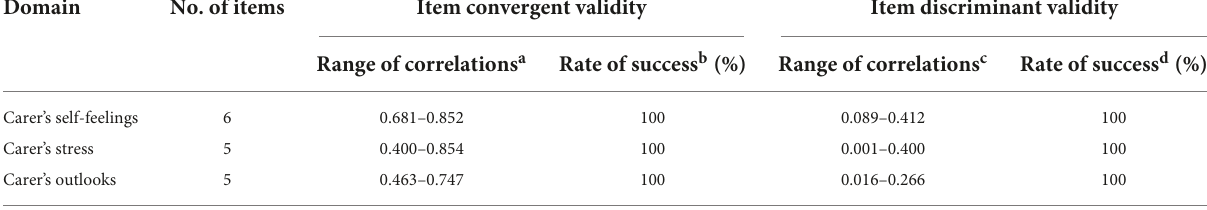
TABLE 3 The convergent validity and discriminant